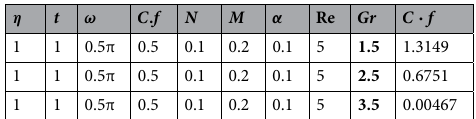
Table 4. Influence of Grashof number Gr on skin friction.